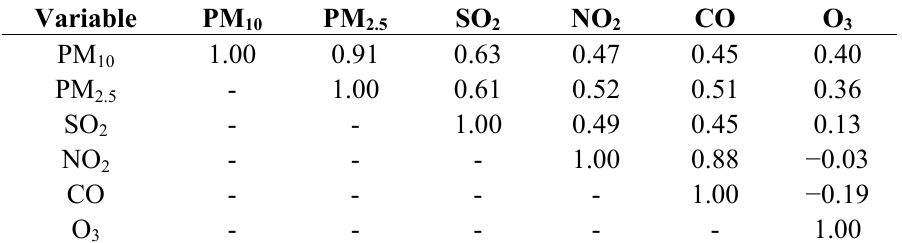
Table 3. Correlation coefficients among air pollutants.